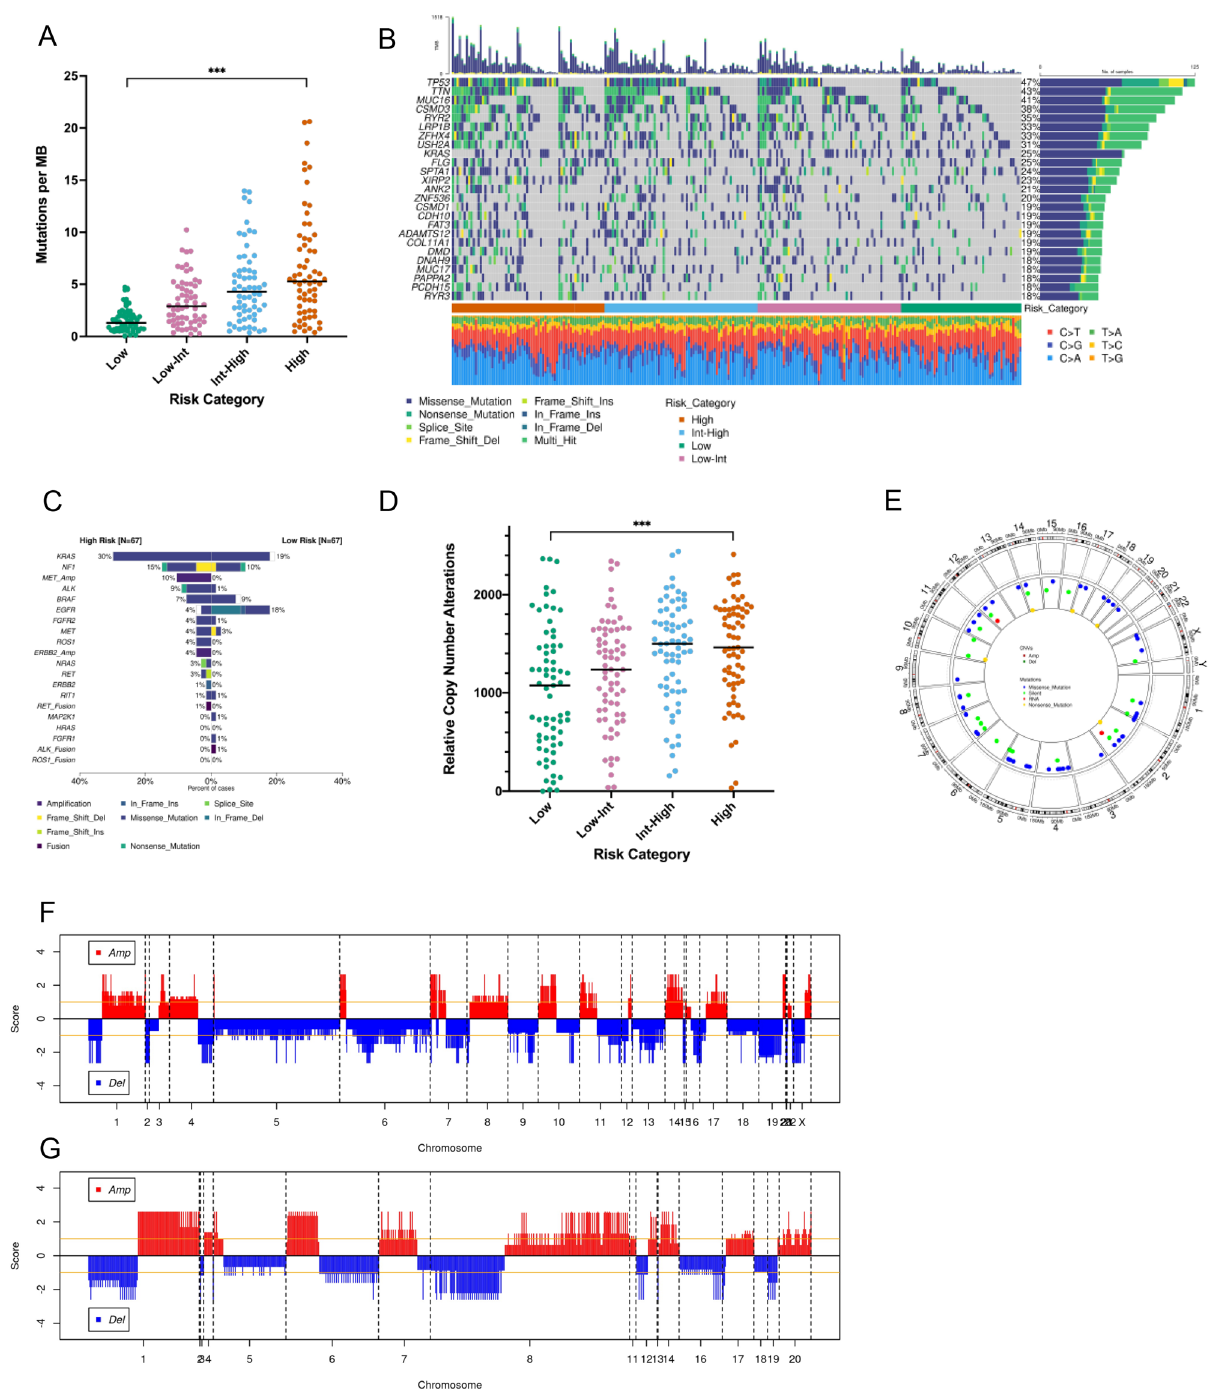
Figure 2. Genetic alterations in recurrent lung adenocarcinomas. Increasing risk of recurrence is associated with increasing tumor mutation burden ( A ). An oncoplot of the most frequently mutated genes in the stage I lung adenocarcinoma cohort is shown in ( B ). Canonical driver mutations are present in stage I tumors but do not occur more frequently in recurrent tumors ( C ). Copy number alterations occur more frequently in tumors with increasing risk of recurrence ( D ). Although copy number alterations and mutations are evenly distributed through the genome in recurrence high-risk tumors ( E ), high-risk ( F ) versus low-risk ( G ) tumors show different genome-wide copy number alteration patterns. *** P <